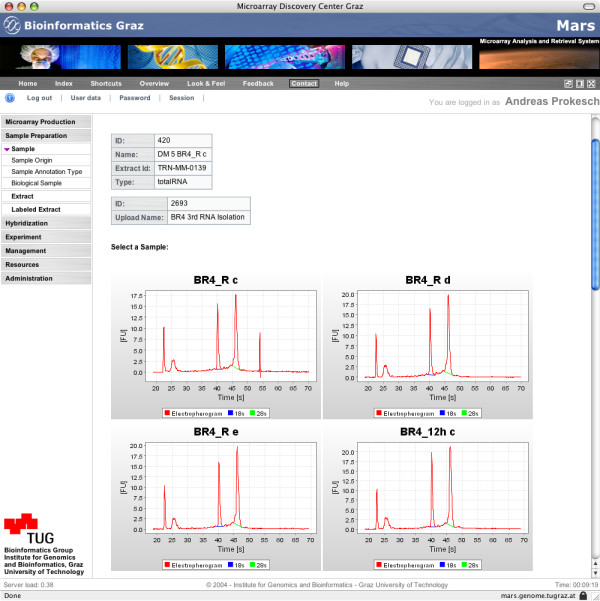
Quality control. Bioanalyzer analysis to check the RNA quality for a given RNA extract.